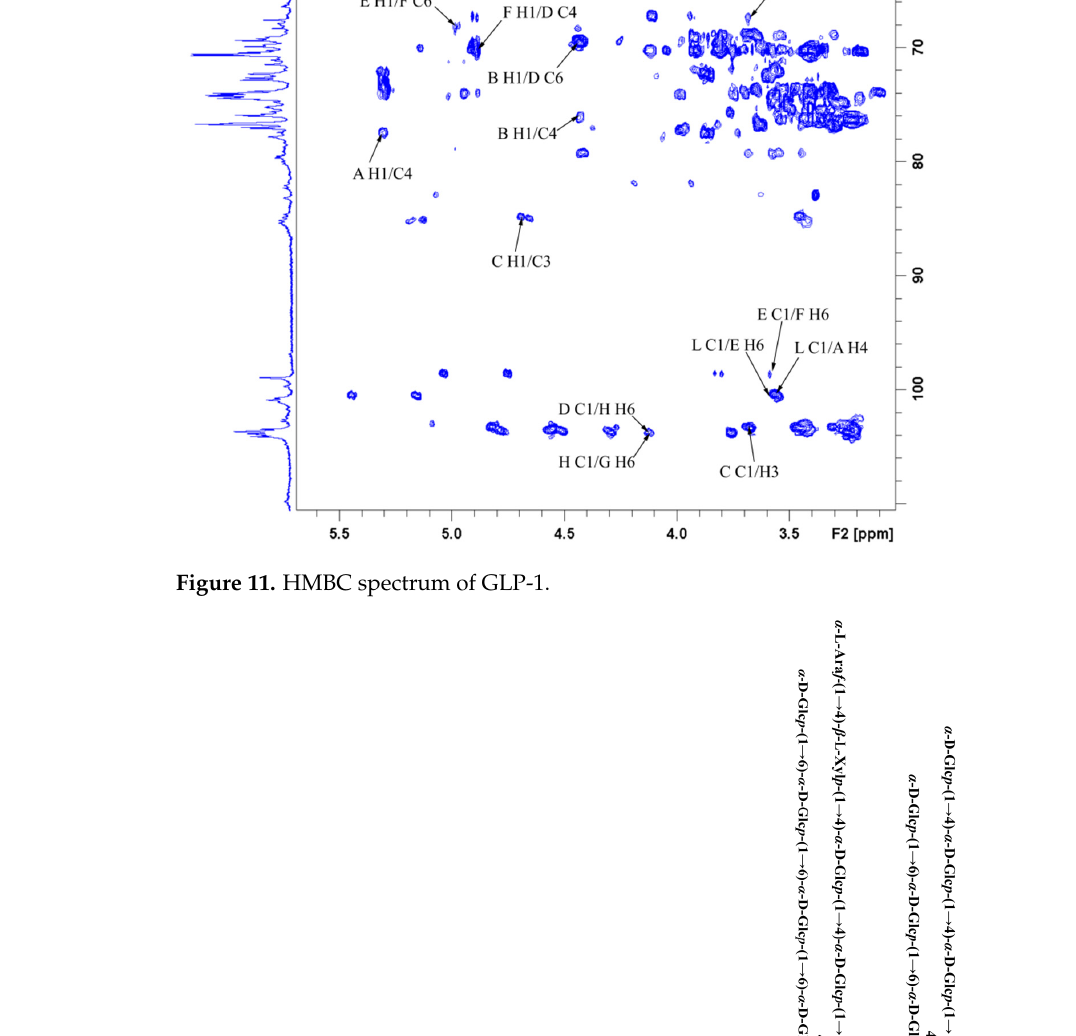
Figure 12. Putative structure of GLP-1.